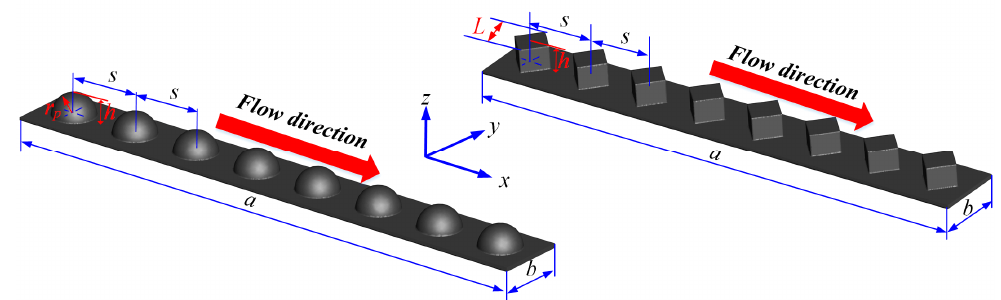
Figure 1. Computational domain of a channel with different dimples.